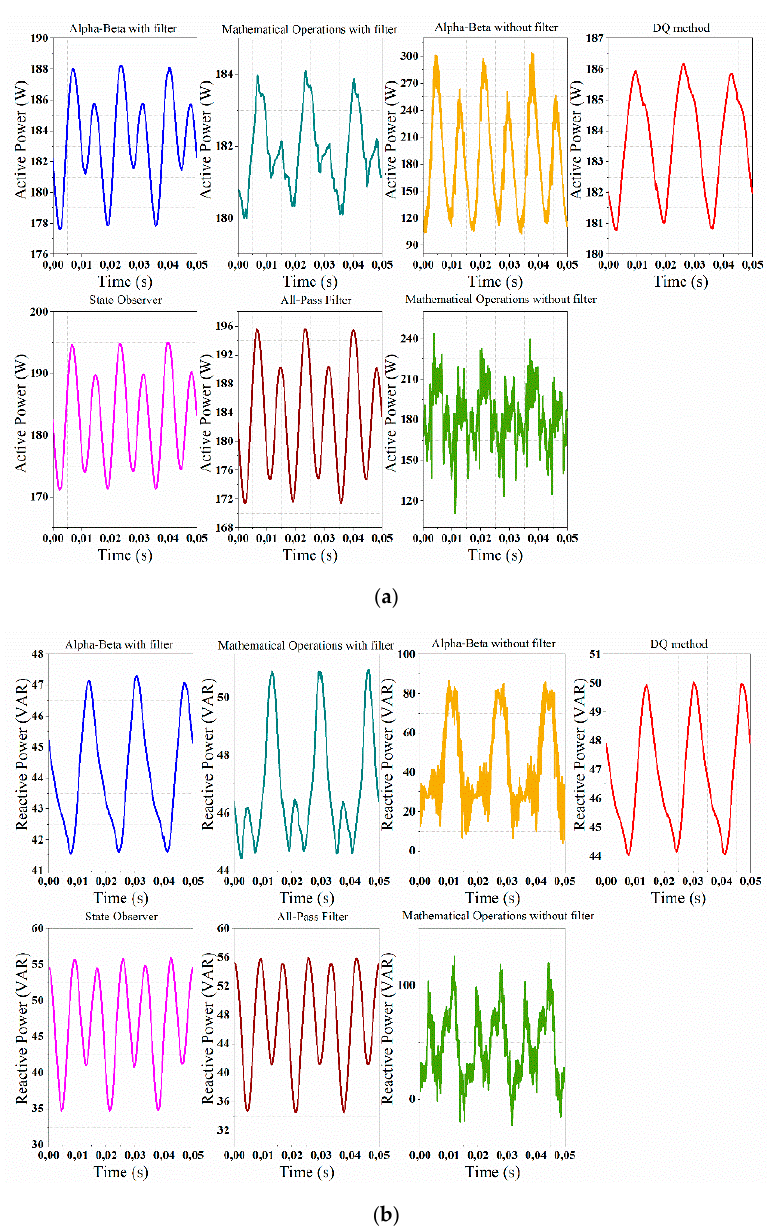
Figure 11. Power calculation methods at the fundamental frequency: ( a ) active power; ( b ) reactive power.